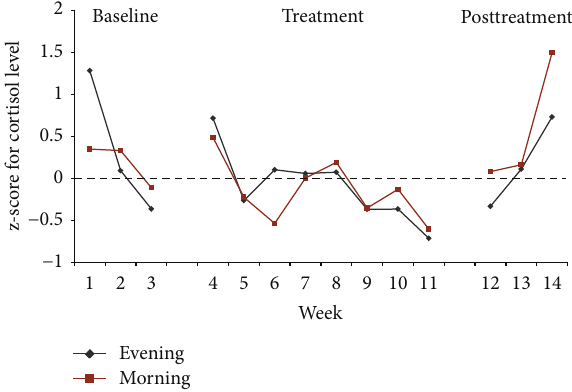
Figure 3: Evening and morning cortisol levels compared to their respective average for participants 1, 2, and 3. 0 as z-score means participant’s average of cortisol levels. A negative z-score means a cortisollevellowerthanparticipant’saveragewhileapositivez-score means a cortisol level higher than participant’s average of cortisol